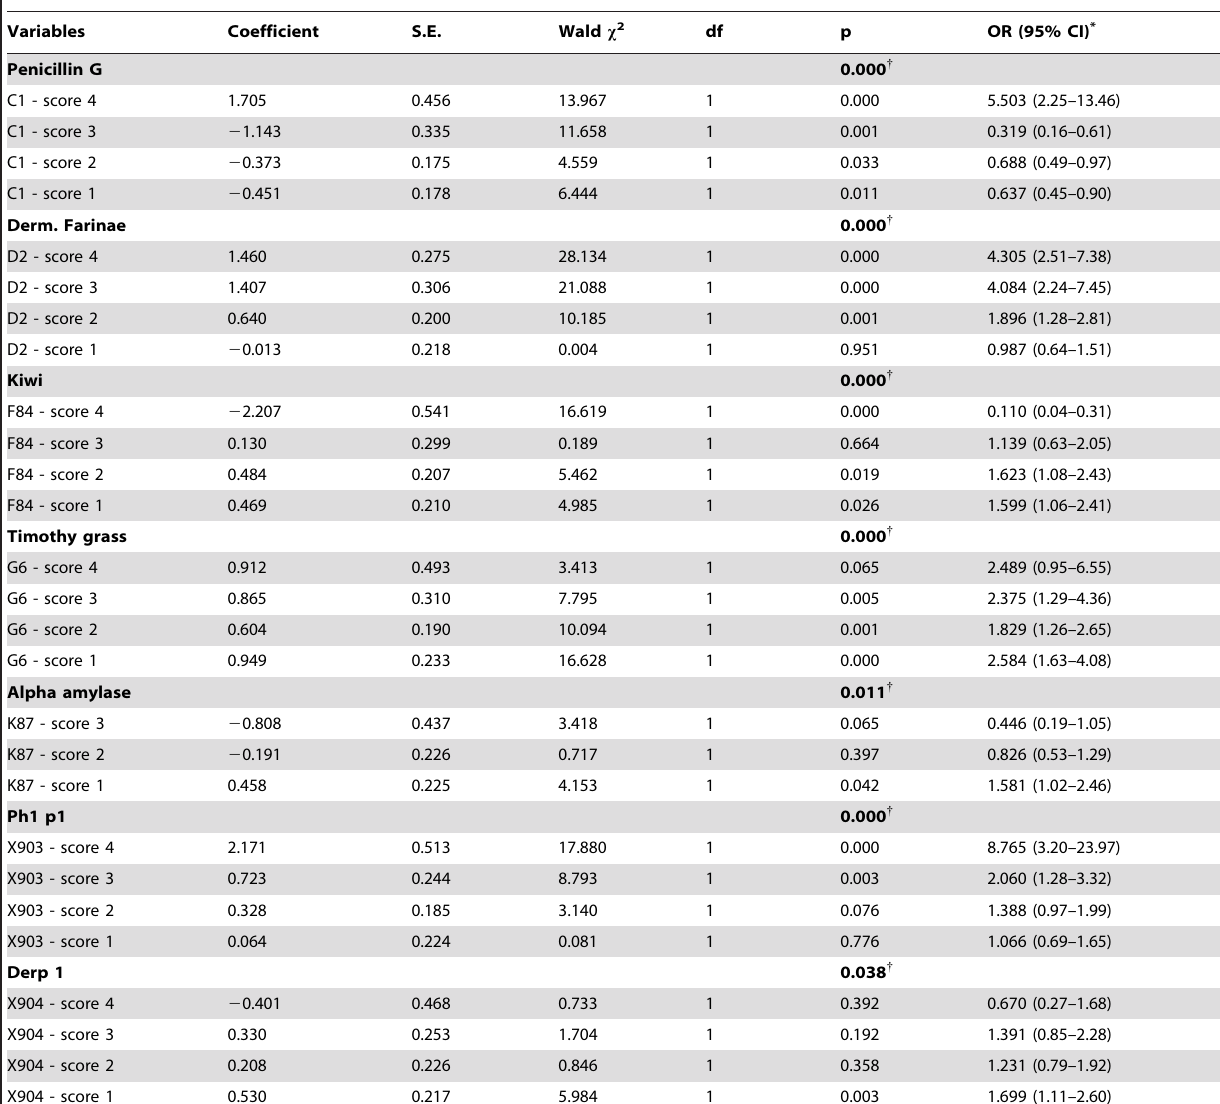
Table 3. Results of multivariate GEE